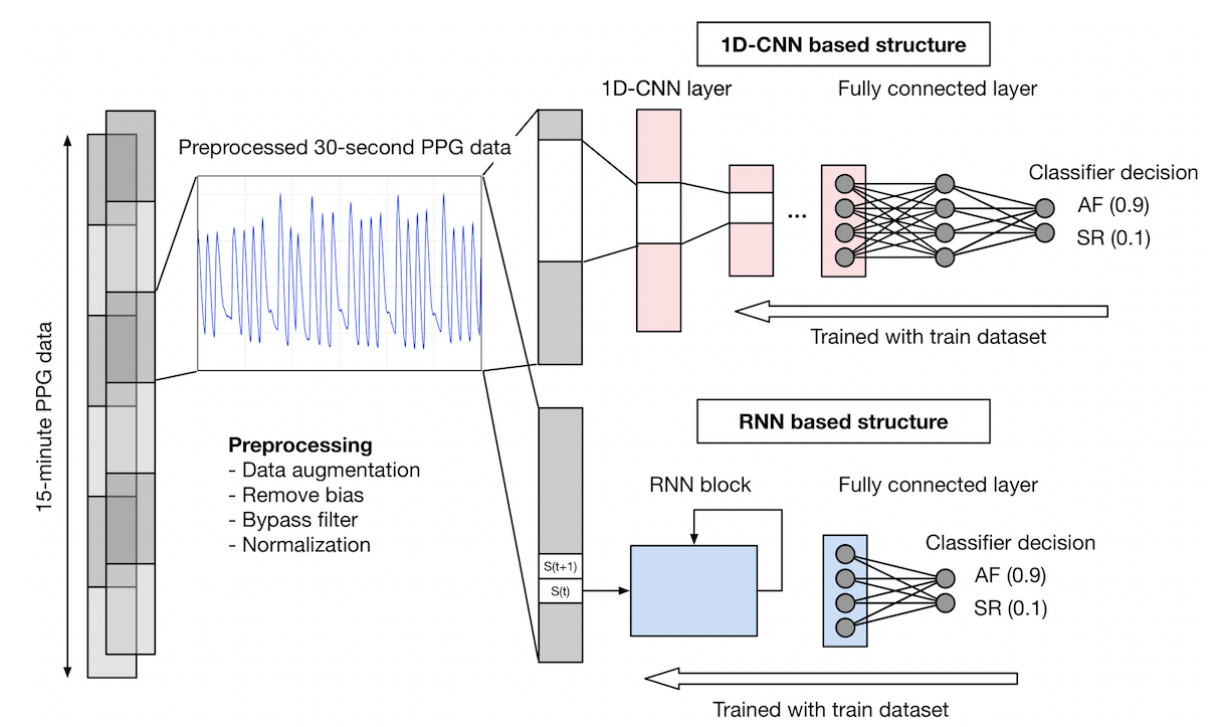
Figure 1. Flowchart illustrating the deep learning process. For each subject, 15-min PPG data during pre- and post- direct-current cardioversion periods were obtained. Each 15-min sample was preprocessed by removing bias, applying bypass filters, and normalization. Then, each sample was subdivided into 30-second samples with 20-second overlaps for data augmentation. The 30-second samples were trained and tested by 1-dimensional convolutional neural network (1D-CNN) and recurrent neural network (RNN) methods. Each sample was labeled as atrial fibrillation (AF) or sinus rhythm (SR). The number in parenthesis shows an example of the corresponding confidence level. In this example, the confidence level for diagnosing AF was 0.9 in 1D-CNN and RNN models, whereas 0.1 in SR for both models. 1D-CNN: 1-dimensional convolutional neural network; AF: atrial fibrillation; PPG: photoplethysmography; RNN: recurrent neural network; SR: sinus